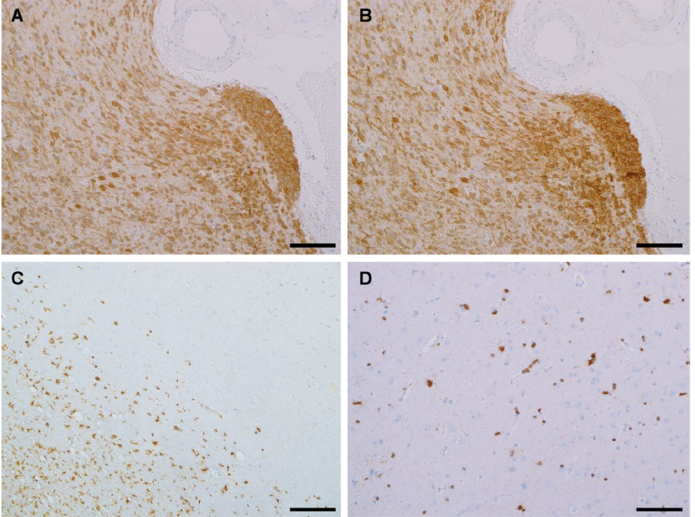
Figure 5. Immunohistochemical demonstration of glioma growth fronts, either with a pushing border (ODG-5; A , B ) or in an infiltrating fashion (ODG-2; C ), and cryptically infiltrating low-grade glioma cells from surrounding brain tissue (BRN-24; D ) using MRQ-67 ( A , C , D ) or H09 ( B ). UltraView, visualized with DAB, and counterstained with hematoxylin. ( A , B , D ) scale bar = 100 µm; ( C ) scale bar = 200 µm.